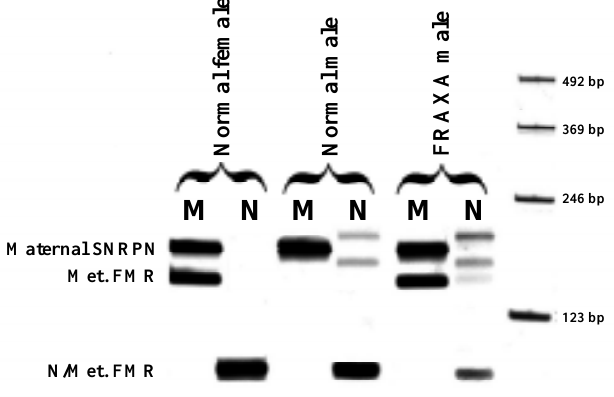
Figure 2 - Polyacrylamide gel electrophoresis of the products of methyla- tion-specific PCR of the human FMR1 gene on the X chromosome. Met. FMR is the 142-bp fragment from the bisulfite-treated methylated CpG is- land, while N/Met. FMR is the 84-bp product from the treated non-meth- ylated promoter. Maternal SNRPN is the internal control 174-bp product of amplification of the imprinted maternal methylated version of the CpG island of the SNRPN gene on human chromosome 15 (Kubota et al. , 1997). DNA samples from a normal woman, a normal man and a patient with the fragile X syndrome diagnosed by chromosomal studies and Southern blot analysis were treated with sodium bisulfite as described by Herman et al. (1996). On the rightmost lane of the gel are the 123-bp ladder molecular size standards (Life Technologies, Gaithersburg, MD,